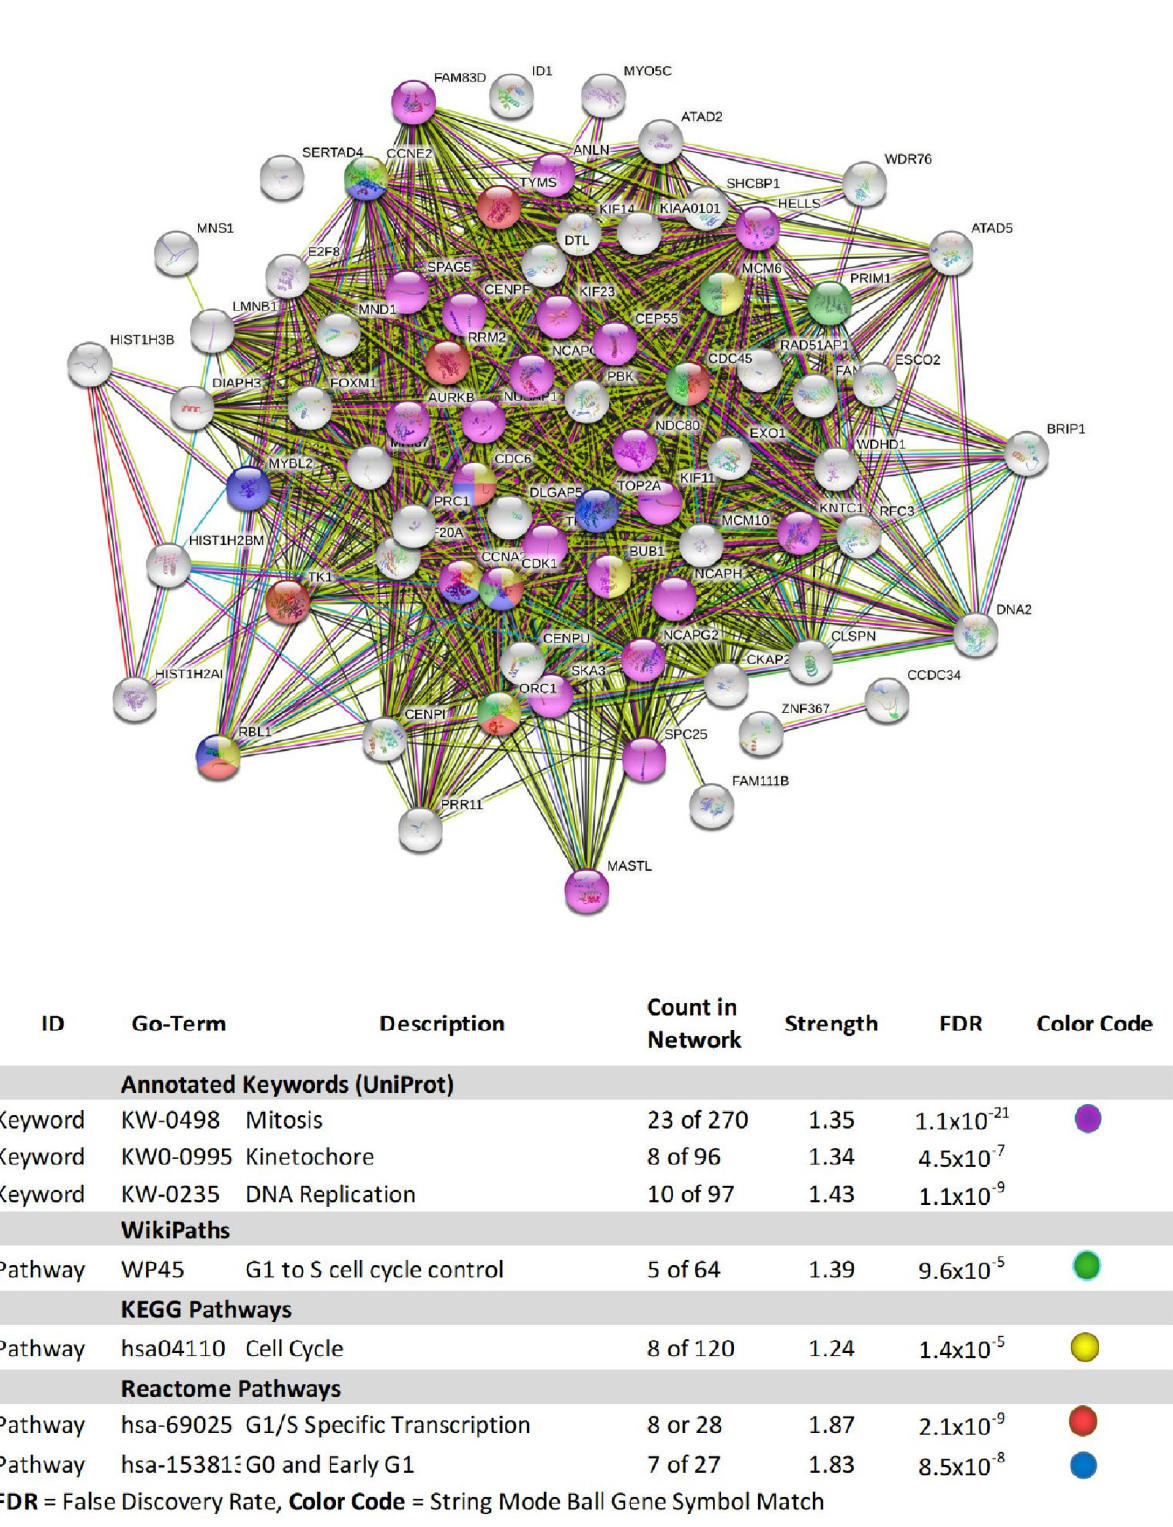
Figure 8. String_db classification of down-regulated DEGs by GNE-140 in MDA-MB-231 cells. The diagram represents gene symbols, which are color-coded by category in the database analysis table. Table data contains database used, ID within each specific database, description of pathway, count in network, strength of association, FDR p -value, and color code for genes involved in that network.